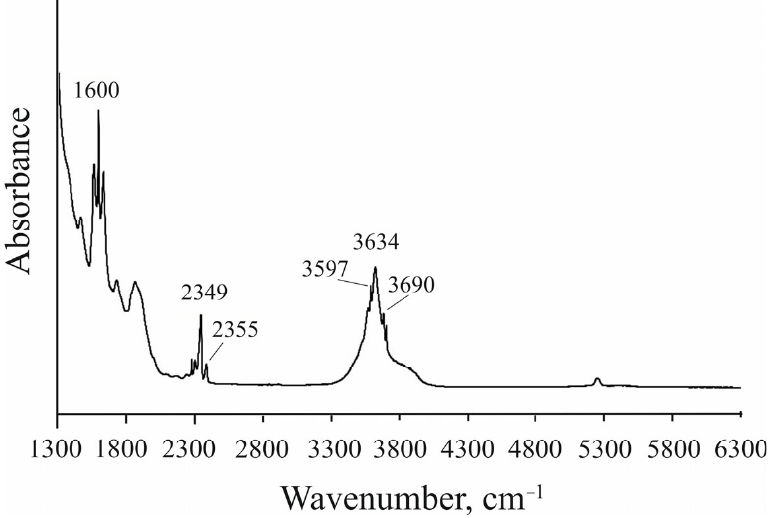
Figure 4. IR spectrum of a cordierite crystal from the Muzkol metamorphic complex, Tajikistan. Absorption bands with frequencies of 1600 (type II) and 3597 (type II), 3634 (type II), and 3690 (type I) cm − 1 correspond to stretching vibrations of water molecules of types I and II in cordierite cavities; absorption bands with frequencies of 2349 (A ‐ type) and 2355 (C ‐ type) cm − 1 correspond to vibrations of carbon dioxide molecules.